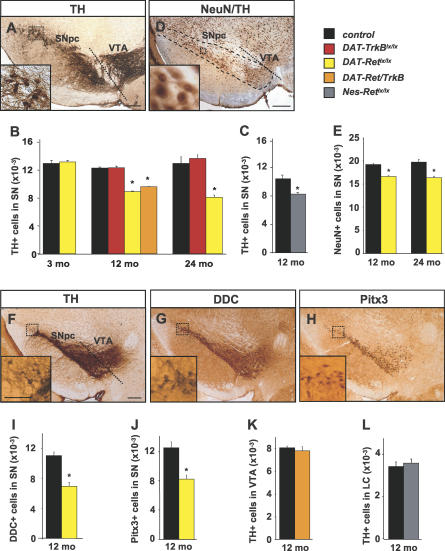
Progressive Loss of Nigral DA Neurons in DAT-Retlx/lx Mice(A) Coronal brain section of a 3-mo-old wild-type mouse showing DA neurons in the SNpc and the VTA stained with an antibody against TH. The inset shows a higher magnification view of the stippled area.(B and C) Stereological quantification of TH-positive DA neurons in the SNpc of 3-, 12-, and 24-mo-old control, DAT-TrkBlx/lx, DAT-Retlx/lx, and double homozygous Dat-Ret/TrkB mice (C) (n = 3 mice per genotype), Nes-Retlx/lx mutant mice and littermate controls (D) (n = 4 mice per genotype). *, p < 0.05 (Student t-test).(D) Double immunostaining for NeuN and TH (very mild staining protocol to outline the SNpc [stippled area]). The inset shows a higher magnification view of the stippled box, displaying nuclear localization for NeuN and cytoplasmic immunoreactivity for TH.(E) Stereological quantification of NeuN-positive neurons in the SNpc of 12- and 24-mo-old control and DAT-Retlx/lx mice (n = 5 mice per genotype at 12 mo, and n = 4 mice per genotype at 24 mo). *, p < 0.0001 and p < 0.001 for 12- and 24-mo-old DAT-Retlx/lx mice, respectively (Student t-test).(F–H) Adjacent sections of SNpc and VTA of a 1-y-old wild-type mouse stained for TH (F), dopa-decarboxylase (G), and Pitx3 (H). Insets show higher magnification images.(I and J) Stereological quantification of DDC-positive (I) and Pitx3-positive (J) cells in the SNpc of 12-mo-old littermate control and DAT-Retlx/lx mice (n = 3 mice per genotype). *, p < 0.05 (Student t-test).(K and L) Stereological quantification of TH-positive cells in the VTA region of 1-y-old control and DAT-Ret/TrkB mutant mice (K) (n = 3 mice per genotype; p > 0.5; Student t-test) and in the LC of 12-mo-old control and Nes-Retlx/lx mutant mice (L) (n = 4 mice per genotype; p >0.5; Student t-test). Scale bar indicates 250 μm and, in insets, 100 μm.